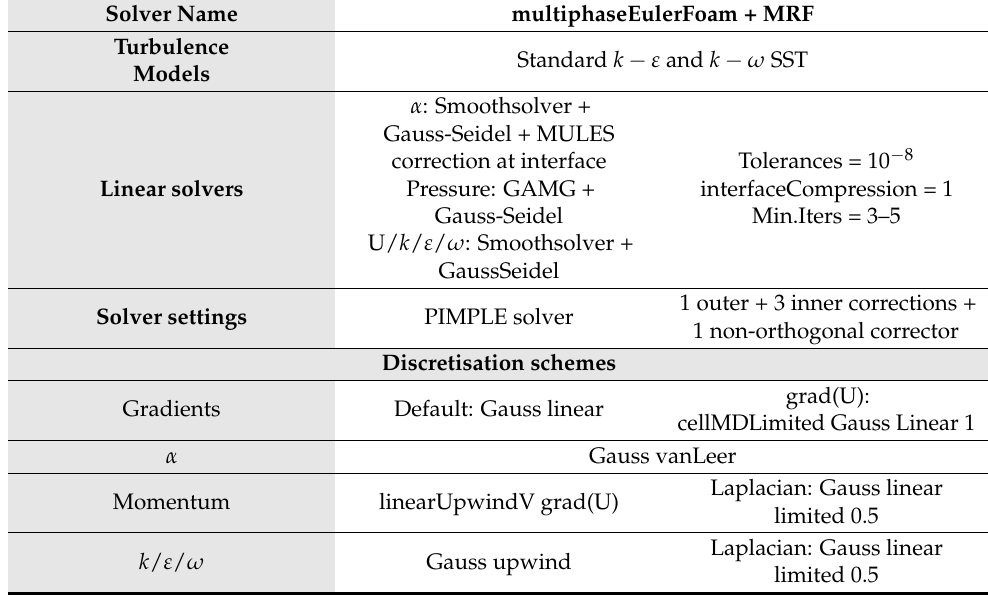
Table 3. Solver settings and models